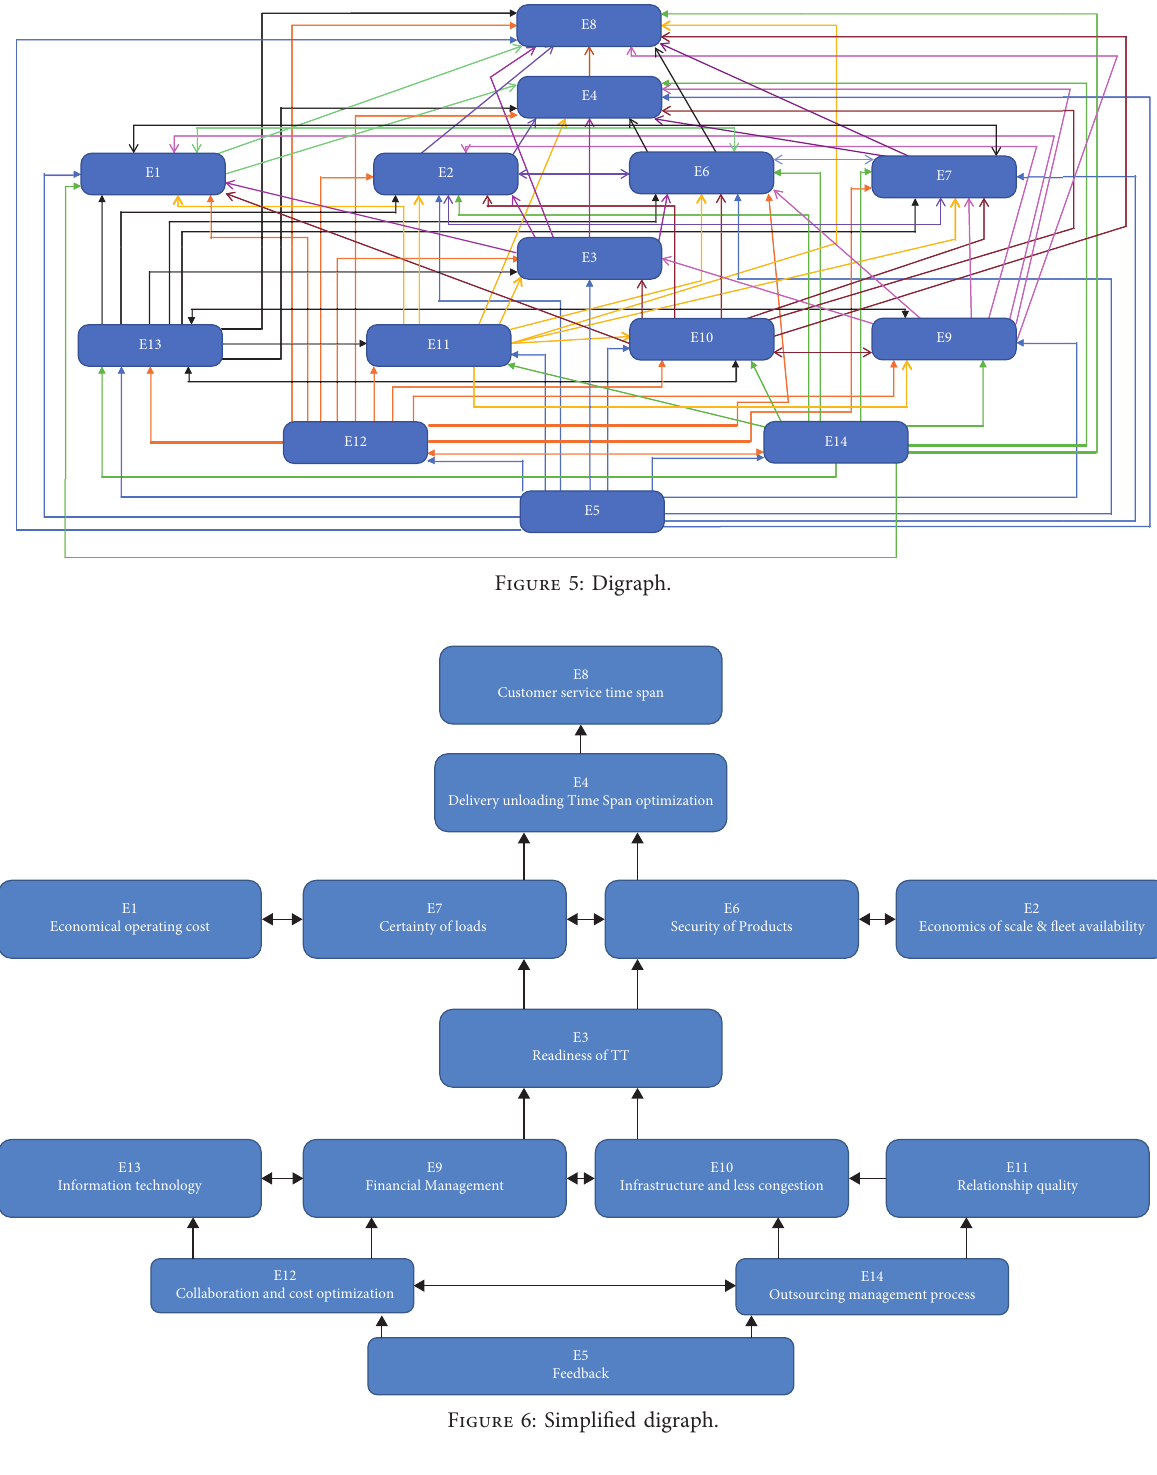
Figure 6: Simplified